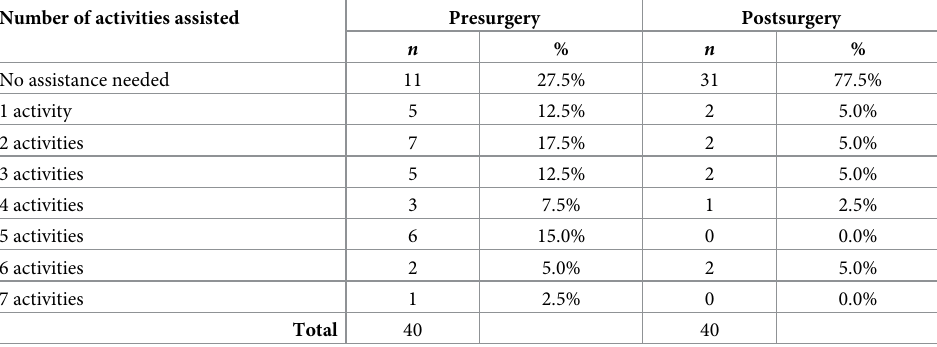
Table 1. Level of assistance caregivers provided to patients pre- and